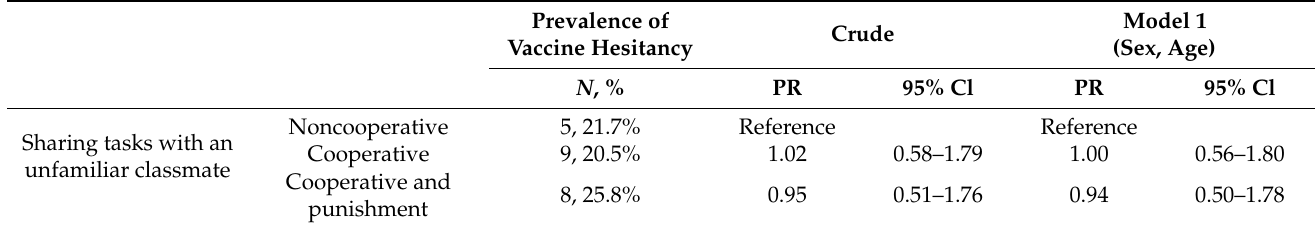
Table 4. Association between sharing tasks with an unknown classmate or a familiar classmate and COVID-19 vaccination